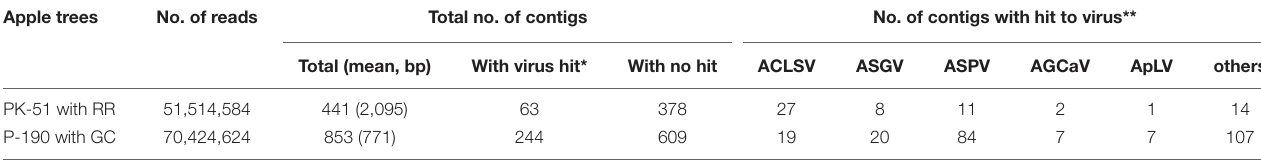
TABLE 1 | Summary of the conventional de novo assembly strategy of the reads from russet ring (RR)- and green crinkle (GC)-diseased apple samples. Apple trees No. of reads